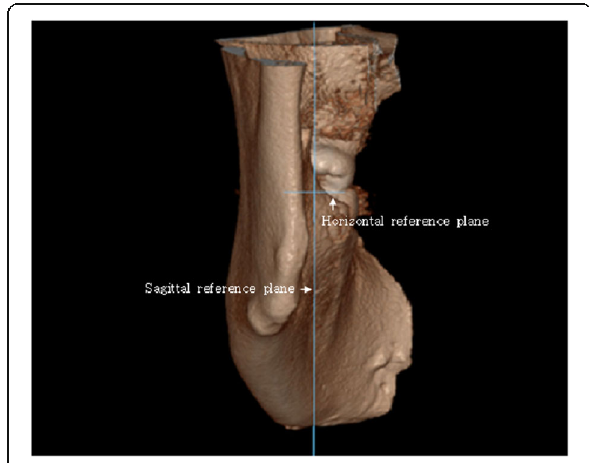
Fig. 2 The plane perpendicular to the occlusal plane and along the line from the cusp of canine to the mesiobuccal cusp of the first molar was set as the sagittal reference plane